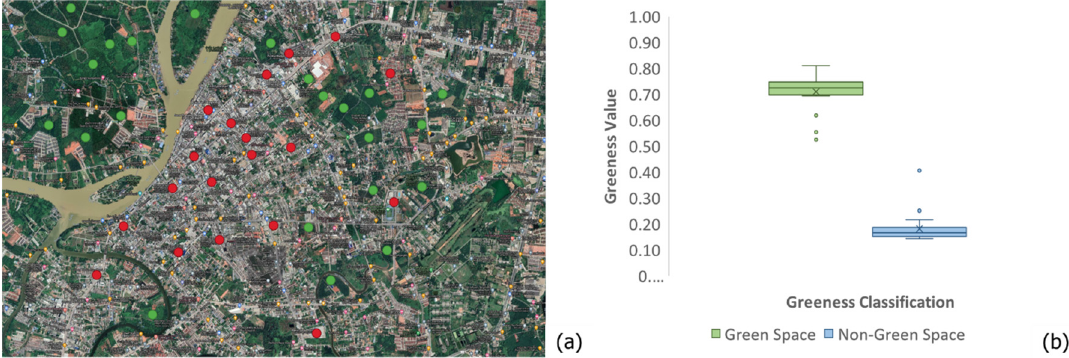
Figure 16. Green space (green circles) and non-green space (red circles) areas in Muang district ( a ) and Box-Whisker plot showing the distribution of their greenness values ( b ).